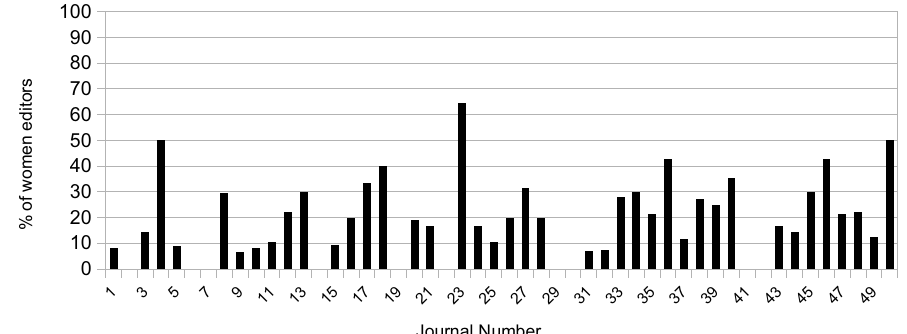
Figure 1. Percentage of Women in Editorial Team of Medical Journals of